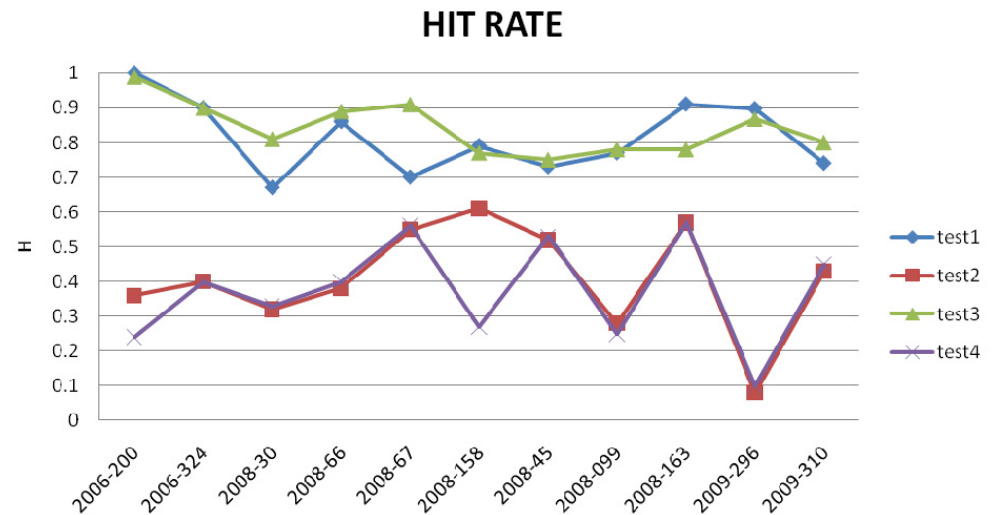
Figure 5. Hit rate values for the different dates and